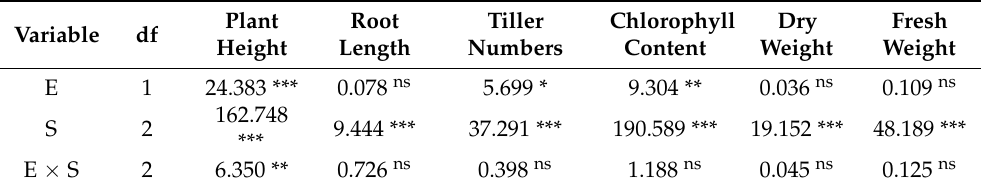
Table 1. Two-way ANOVA for the effects of endophyte (E) and CdCl 2 stress(S) on plant height, root length, tiller numbers, Chlorophyll content, dry weight, fresh weight, of Hordeum brevisublatum .